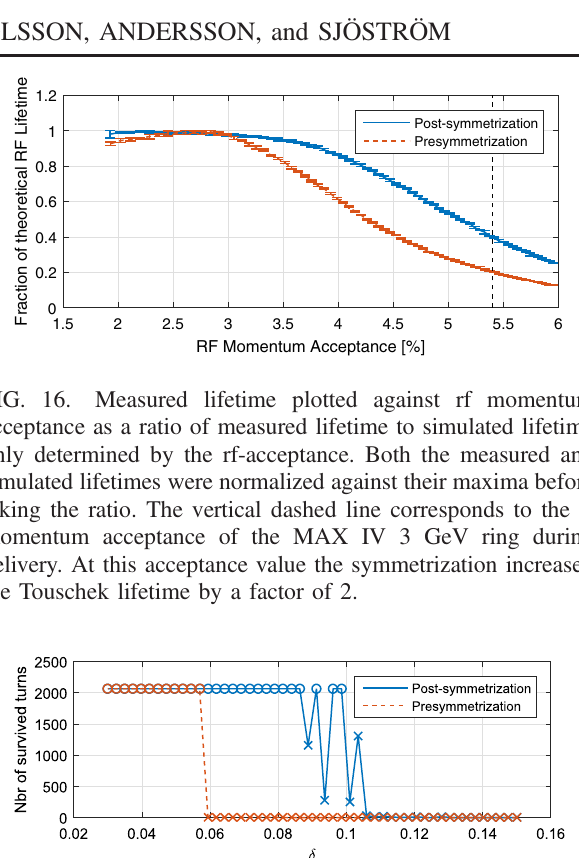
FIG. 17. Number of survived turns for a particle with momen- tum deviation δ propagating in the model fitted to the pre- and post-symmetrization OEORM measurements. A momentum acceptance increase of ∼ 50% can be seen. The simulation was run for 2064